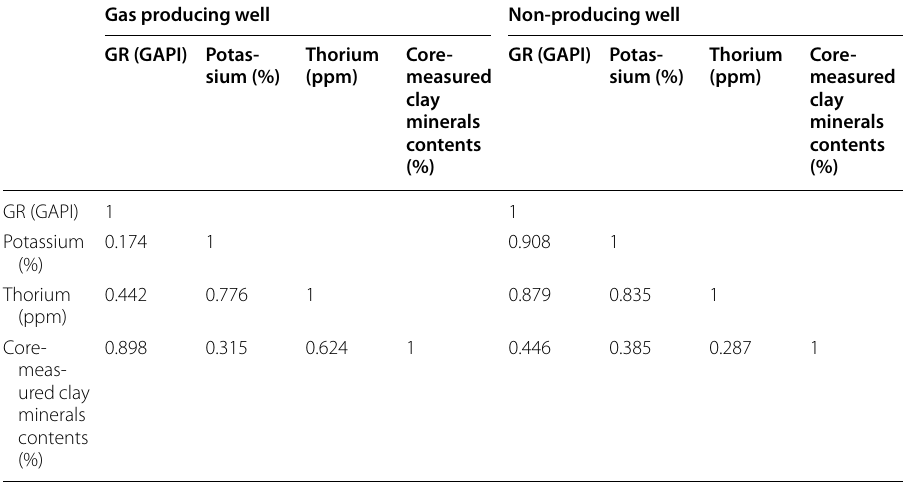
Table 3 The Pearson’s correlation coefficient between log values and the core-measured